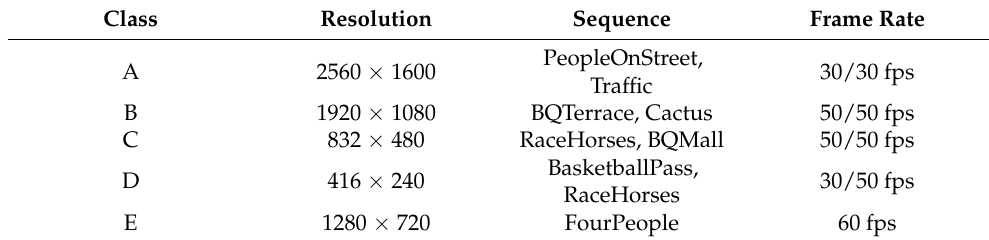
Table 3. Training sample test sequence.